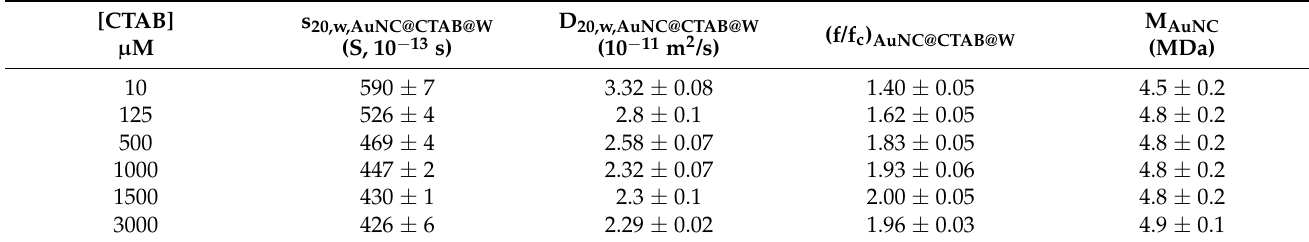
Table 1. Data at 20 ◦ C obtained from the analysis of sedimentation velocity behaviour of 9 nm AuNCs using the density of Au as a priori knowledge: s 20,w,AuNC@CTAB@W , D 20,w,AuNC@CTAB@W , and (f/f c ) AuNC@CTAB@W , and molar mass of AuNC (M AuNC ).